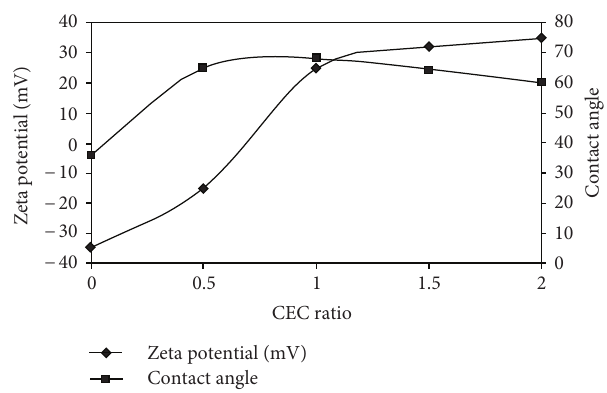
F 4: e variation of zeta potential and contact angle depend on surfactant